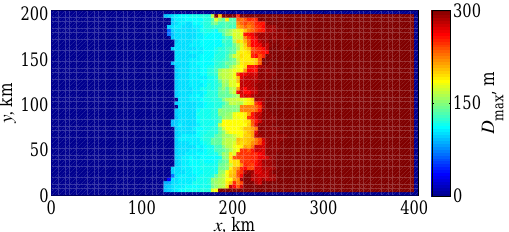
Figure 8. Same as 7b, but where N floes is simply interpolated from the neXtSIM mesh onto the WIM grid and then back again after each coupling time step. Note the boundary between the pack ice and the MIZ has diffused over a large number of grid cells, whereas it remains much sharper when N floes is calculated directly on the neXtSIM